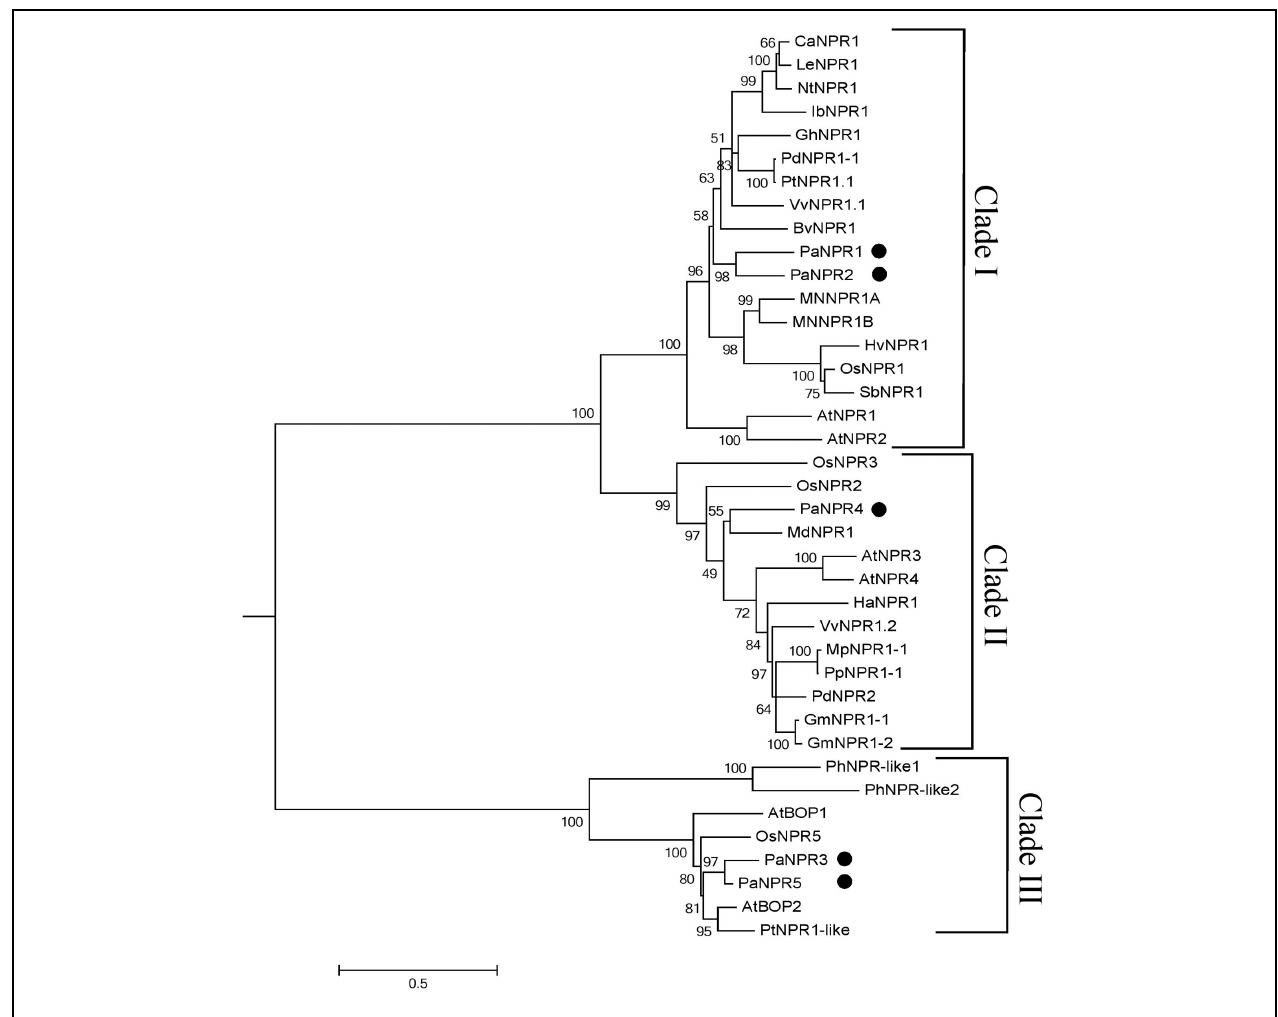
FIGURE 2 | Phylogenetic analysis of the NPR1-like family of proteins from P. americana and several other species. A phylogenetic tree of five NPR1-like proteins from P. americana as well as NPR1-like proteins from other vascular and non-vascular plant species, including the NPR1-like family from